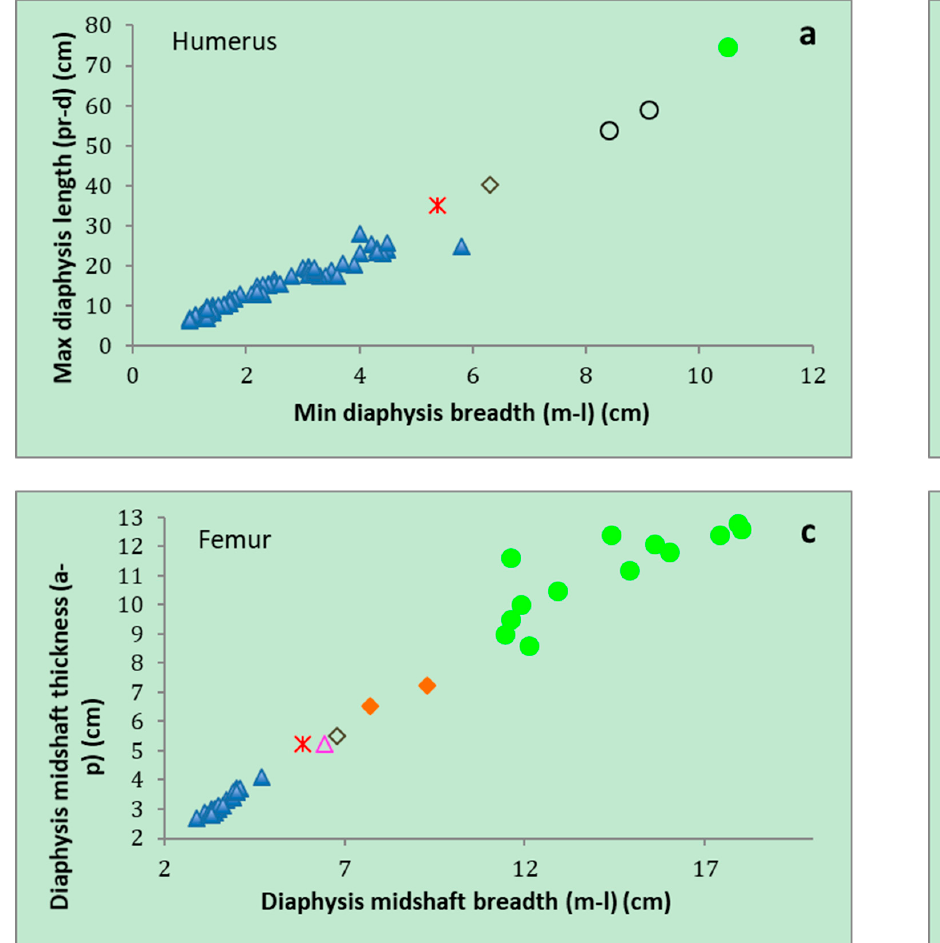
Figure 4. Dimensions of the long bones ( a ) Humeral min diaphysis breadth (m-l) vs. min diaphysis height (pr-d); ( b ) Humeral min diaphysis breadth (m-l) vs. diaphysis breadth (m-l) at deltoid tubercule; ( c ) Femoral diaphysis midshaft breadth (m-l) vs. diaphysis midshaft thickness (a-p); ( d ) Tibial diaphysis midshaft breadth (m-l) vs. max height (pr-d) including epiphyses. Data sources: P. antiquus from Palombo et al., unpublished; for Contrada Fusco and San Teodoro Cave (Table 2 in [5]). Measurements of P. ex gr. P. falconeri are from [40]. All remaining data are original. Refer to Figure 3b for figure